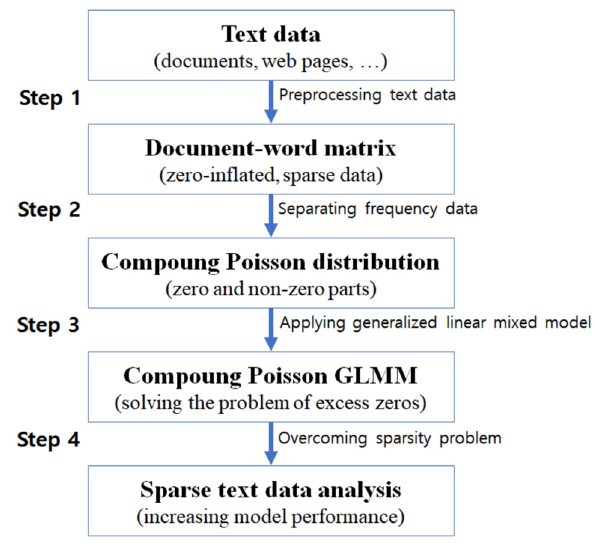
Figure 2. Procedure of proposed method.